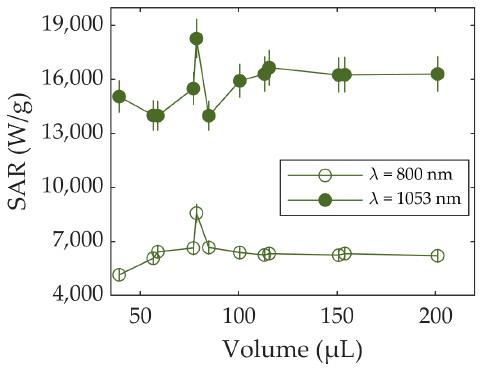
Figure 7. SAR vs. volume for IRA 980B using lasers at 800 nm and 1053 nm. Errors are represented as vertical bars.